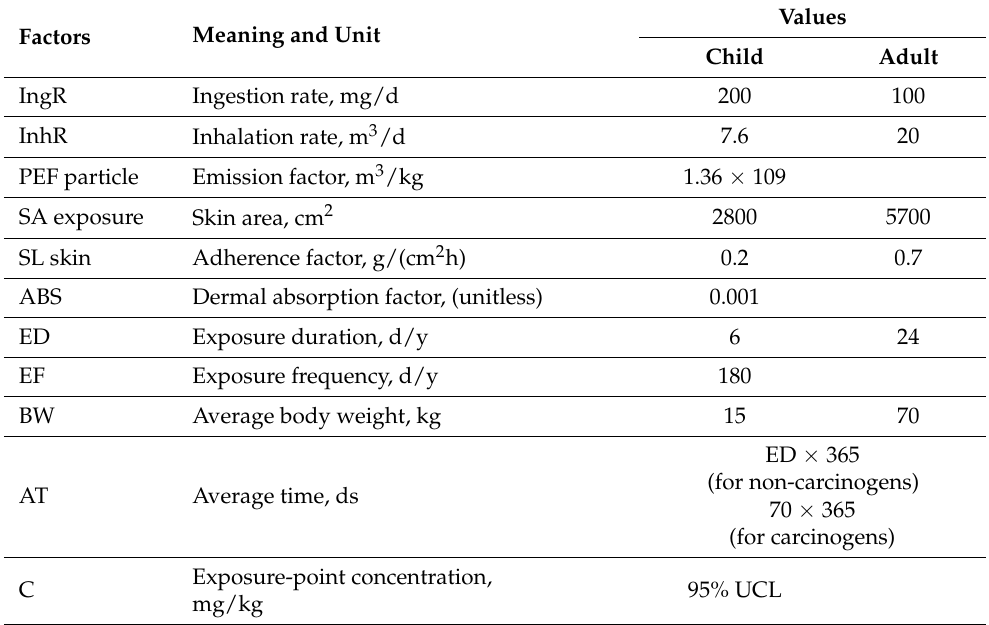
Table 1. Parameter meaning and value of daily dose model of PAHs metals in urban surface dusts. Factors Meaning and Unit IngR Ingestion rate, mg/d 200 100 InhR Inhalation rate, m 3 /d 7.6 20 PEF particle Emission factor, m 3 /kg 1.36 × 109 SA exposure Skin area, cm 2 2800 5700 SL skin Adherence factor, g/(cm 2 h) 0.2 0.7 ABS Dermal absorption factor, (unitless) 0.001 ED Exposure duration, d/y 6 24 EF Exposure frequency, d/y 180 BW Average body weight, kg 15 70 AT Average time, ds